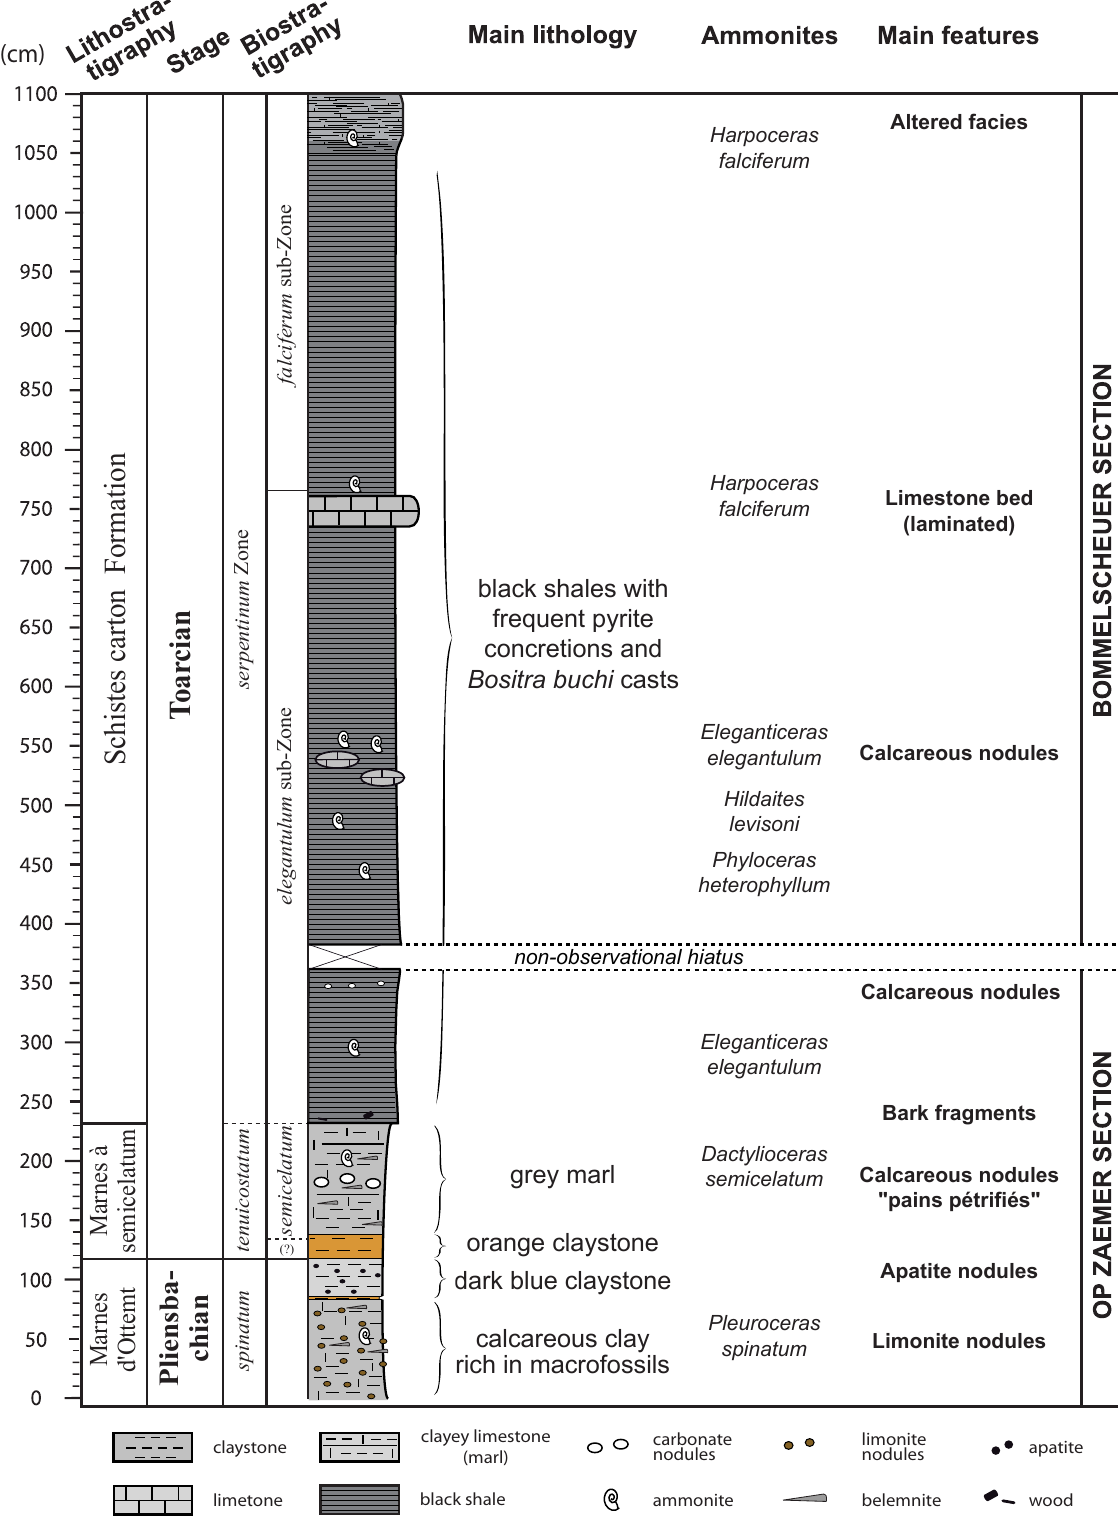
Figure 2. Lithostratigraphy, biostratigraphy and main lithological description of the composite section of Bascharage spanning the Late Pliensbachian to Early Toarcian intervals of the Op Zämer and Bommelscheuer outcrops.